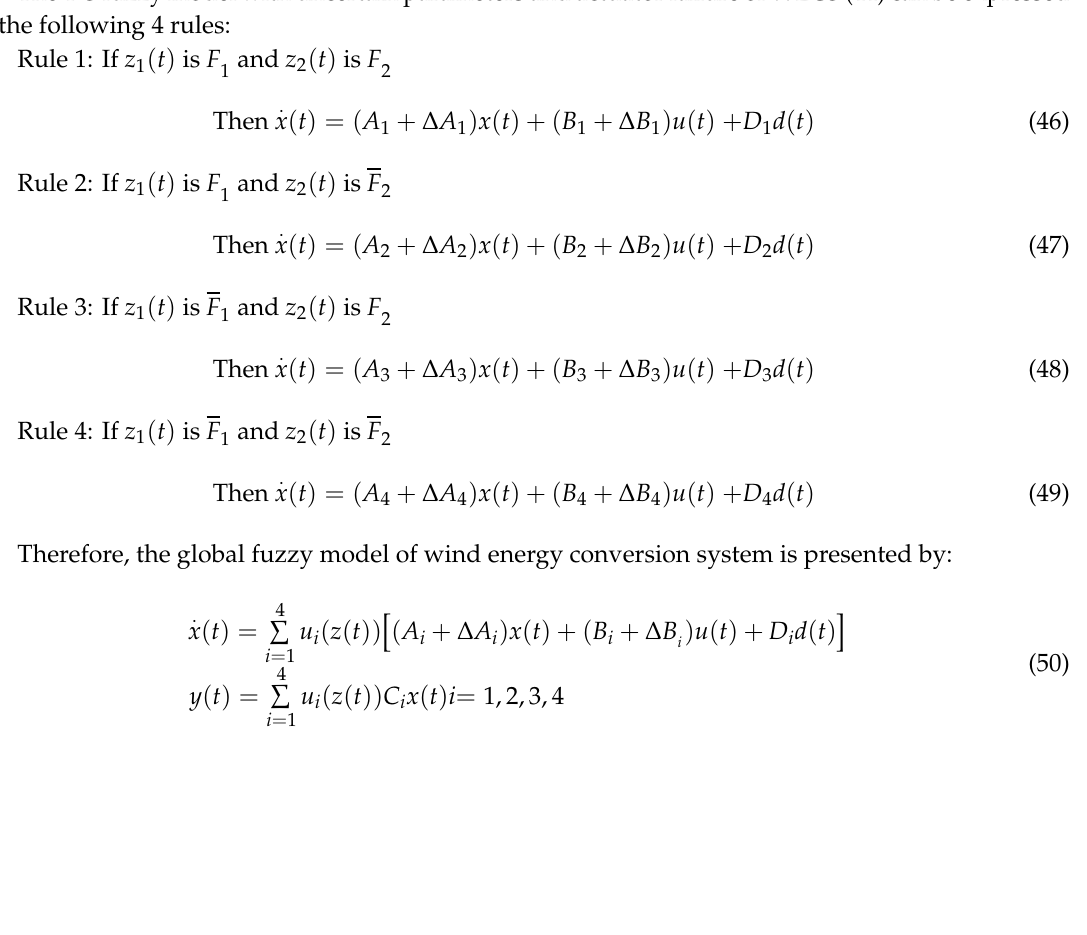
z (t) . Figure 2. The membership functions of z ( t ) 1 1